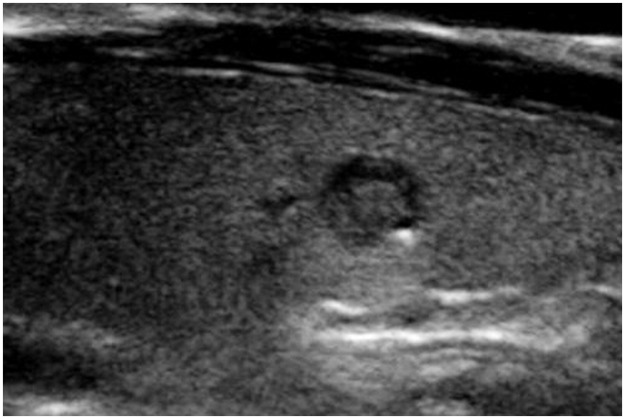
A 31-year-old woman with papillary thyroid carcinoma.Longitudinal sonogram shows a 5-mm, smooth, solid hypoechoic nodule in the right thyroid lobe. The echogenic focus (solid arrow) is located at the margin of intra-nodular micro-cyst. Comet-tail artifact was detected in the solid component (Type 2).